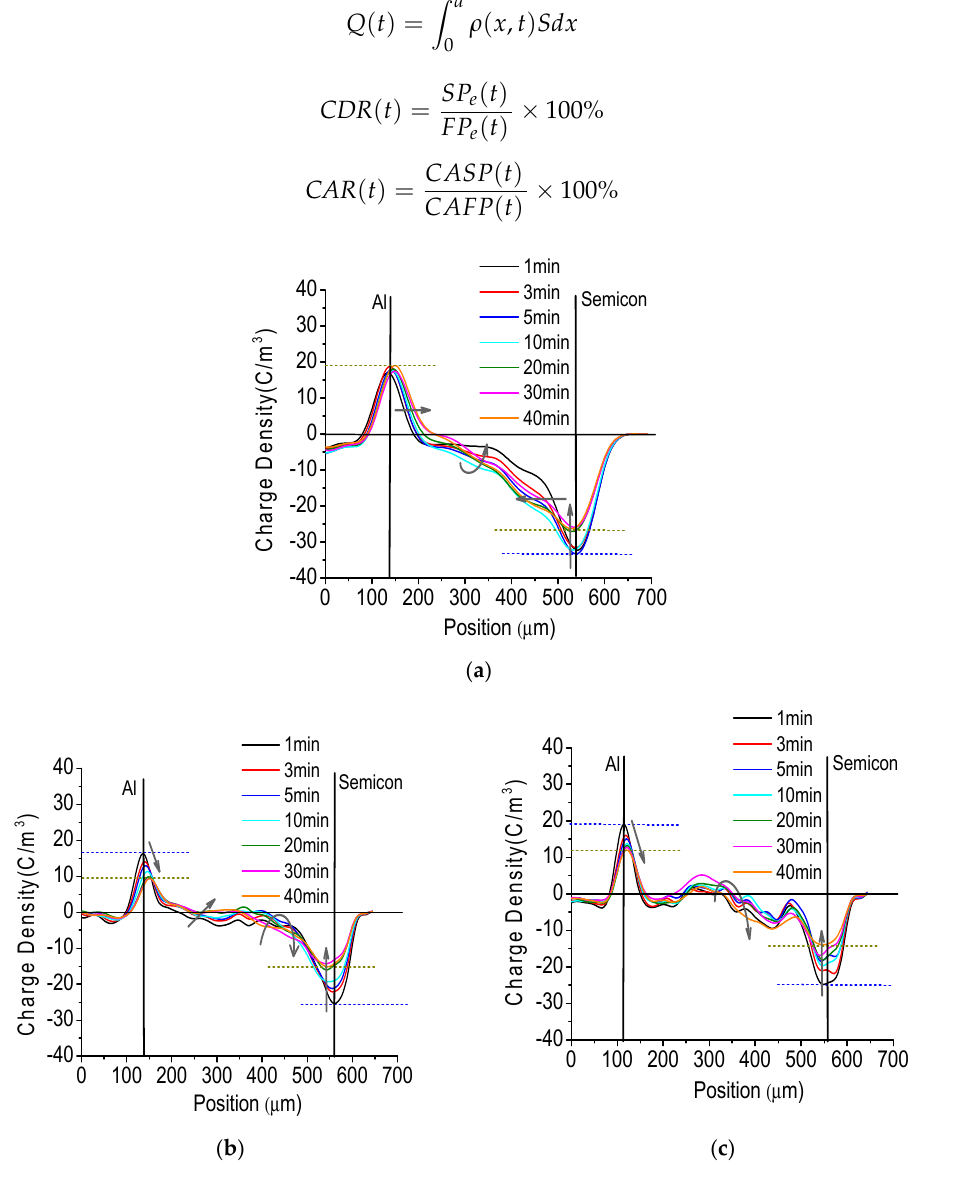
Figure 9. The space charge behavior of the oil impregnated fresh pressboard ( a ); the oil impregnated pressboard surface sputtered Al 2 O 3 film for 60 min ( b ) and 90 min ( c ) under direct current (DC) 15 kV/mm.